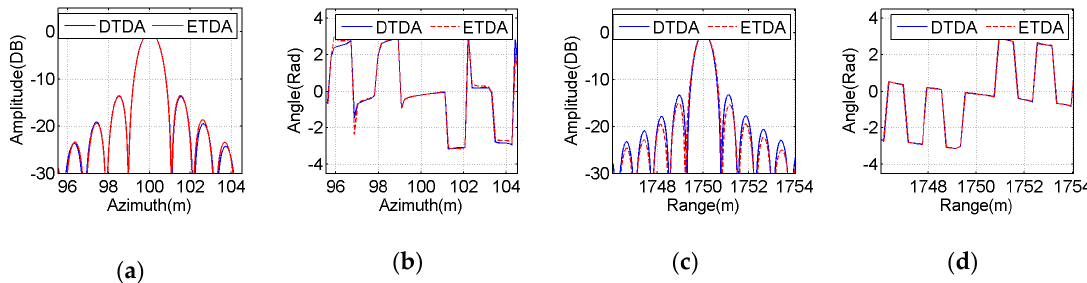
Figure 11. Comparison between the focused results obtained by the bistatic DTDA and proposed ETDA for the point-like scatterer C. ( a ) Azimuth amplitude; ( b ) Azimuth phase; ( c )Range amplitude; ( d ) Range phase.